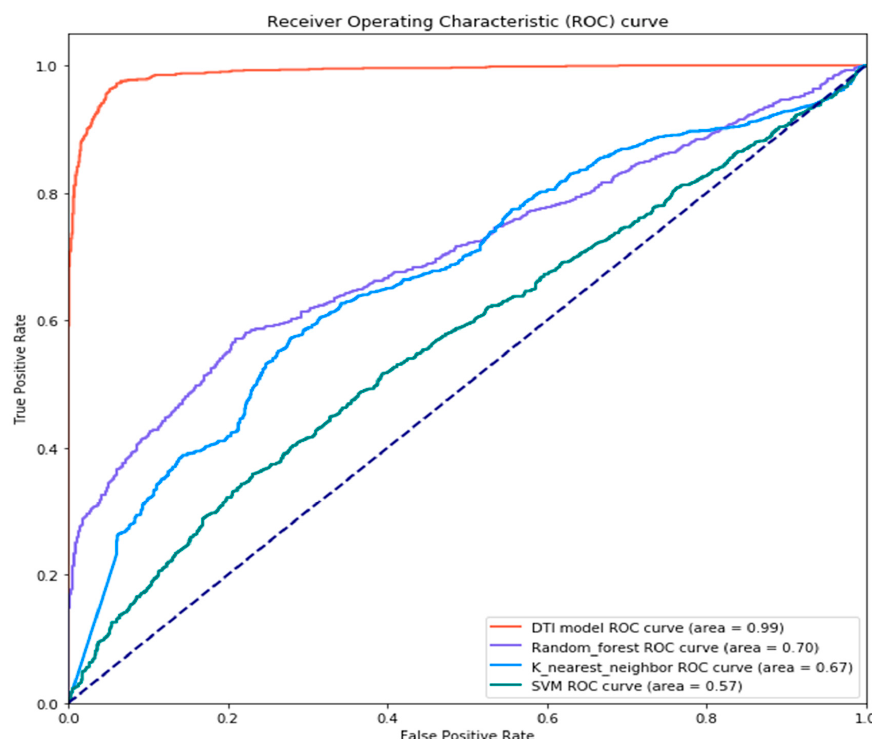
Figure 7. The receiver operating characteristic (ROC) curves and AUC (area under the curve) scores for DTI model based on DNN, random forest, K-nearest neighbor (KNN) and Support Vector Machine (SVM). The dotted line on the diagonal indicates the virtual model without predicted value due to random prediction and is the boundary for judging whether the model performs well. On the upper left of the dotted line, the model is better than the randomly predicted model; contrarily, on the right lower of the dotted line, the model is worse than the randomly predicted model. The “area” in the parenthesis of each label denotes the AUC score.